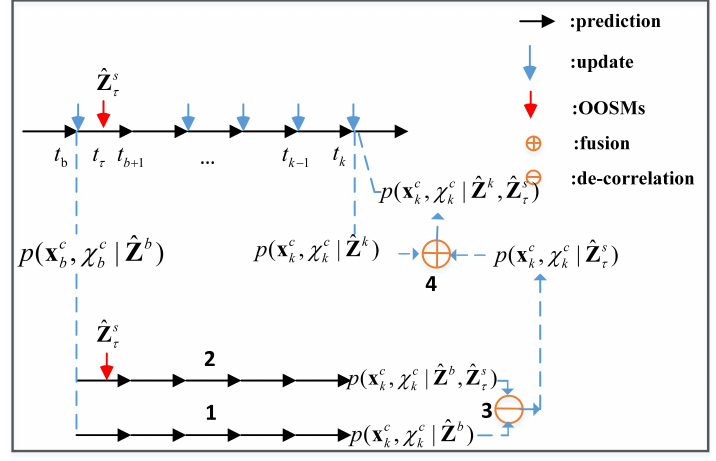
Figure 2. Flowchart of the proposed